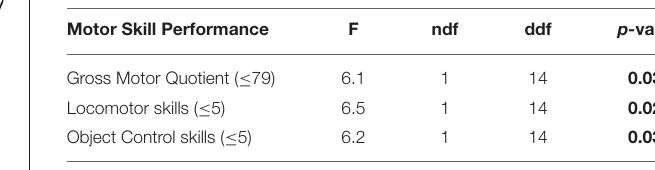
TABLE 2 | Chi-square analyses compare motor skills performance between children with and without